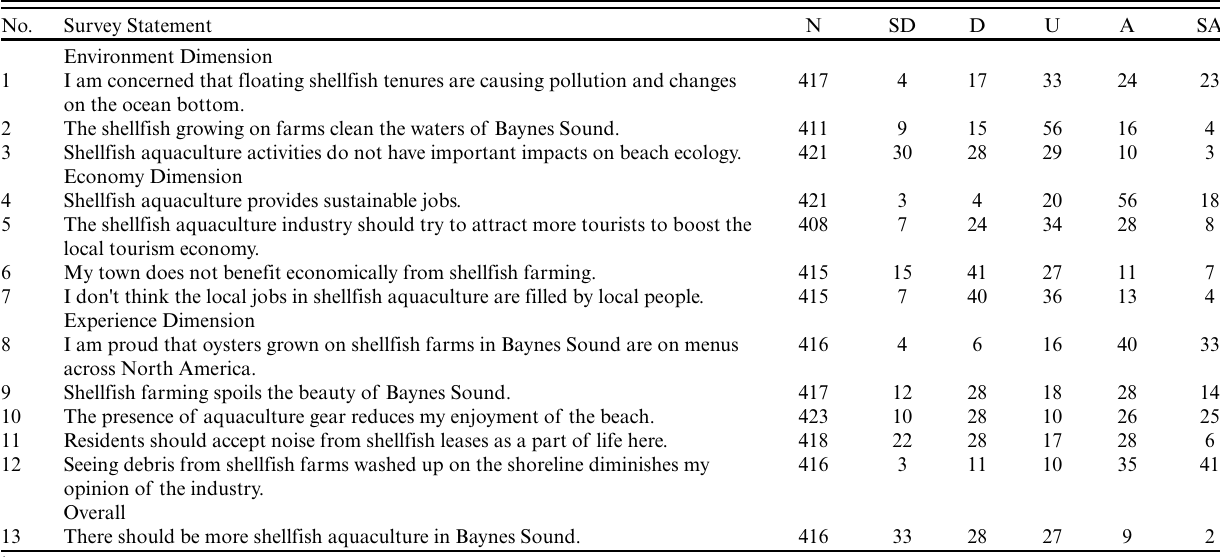
Table 2 . Survey responses to value statements † about perceived effects of shellfish aquaculture as the percentage of respondents in each response category. N = number of respondents who provided an answer to the statement. Possible responses were SD = strongly disagree; D = disagree; U = uncertain; A = agree; SA = strongly agree.